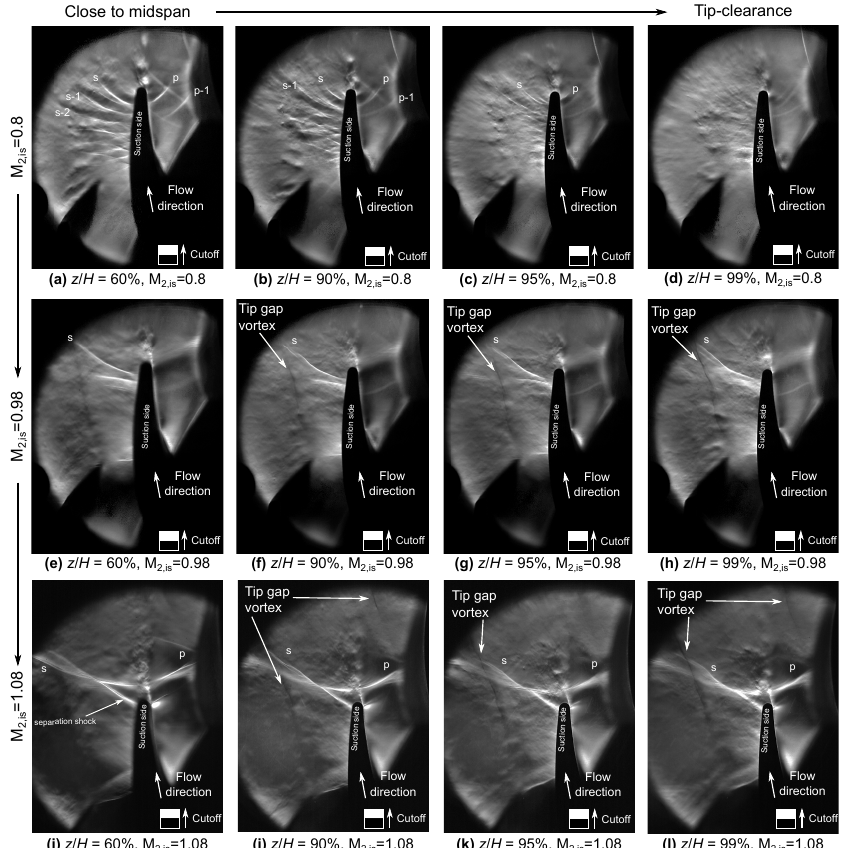
Figure 11. Focusing schlieren images of the linear cascade test section for two mean exit Mach numbers of M 2, is = 0.8 ( a )–( d ), M 2, is = 0.98 ( e )–( h ), and M 2, is = 1.08 ( i )–( l ) at 0 ◦ incidence and a tip-clearance of τ / H = 2%. The field-of-view corresponds to the labeled area in Figure